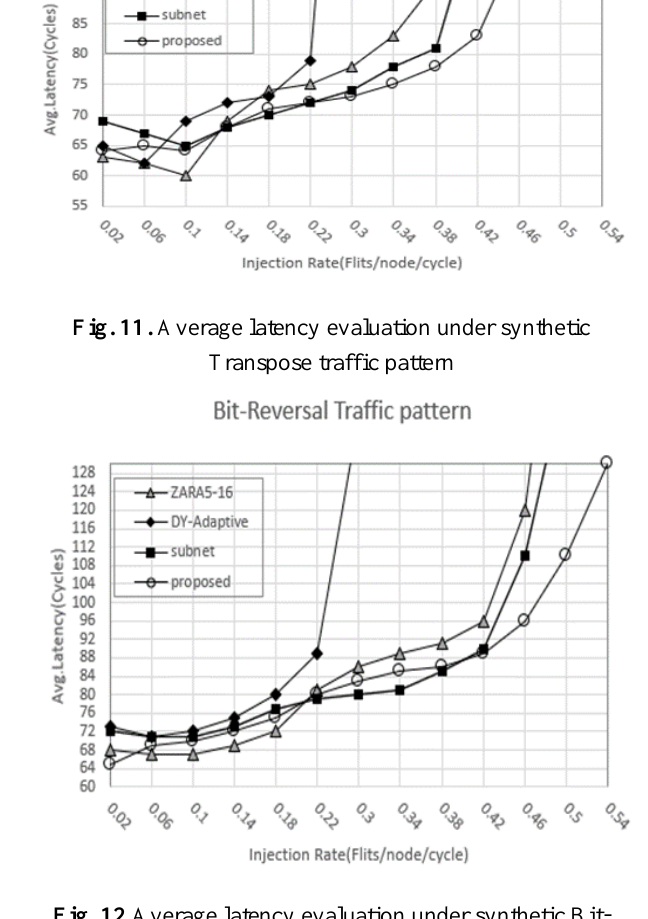
Fig. 12 Average latency evaluation under synthetic Bit- Reversal traffic